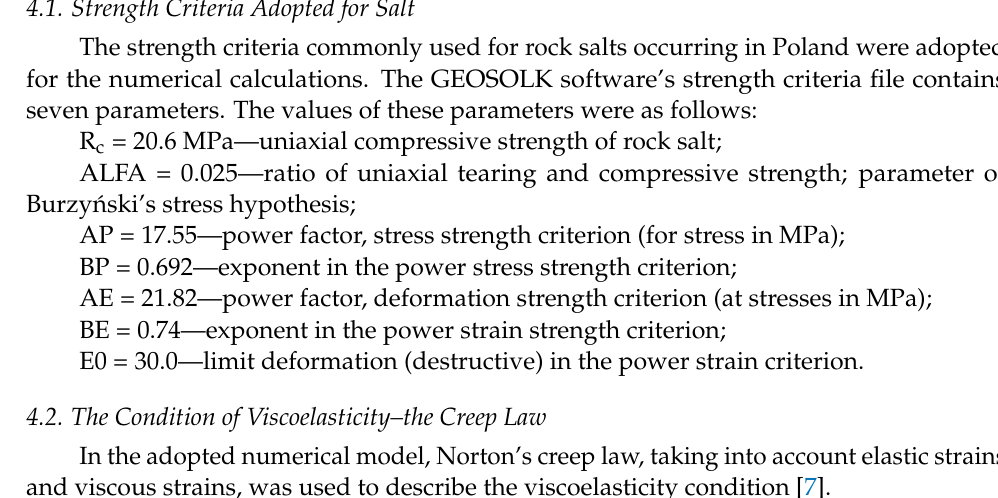
Figure 4. Schematic presentation of the modeling procedure of the CAES cavern operation cycle.